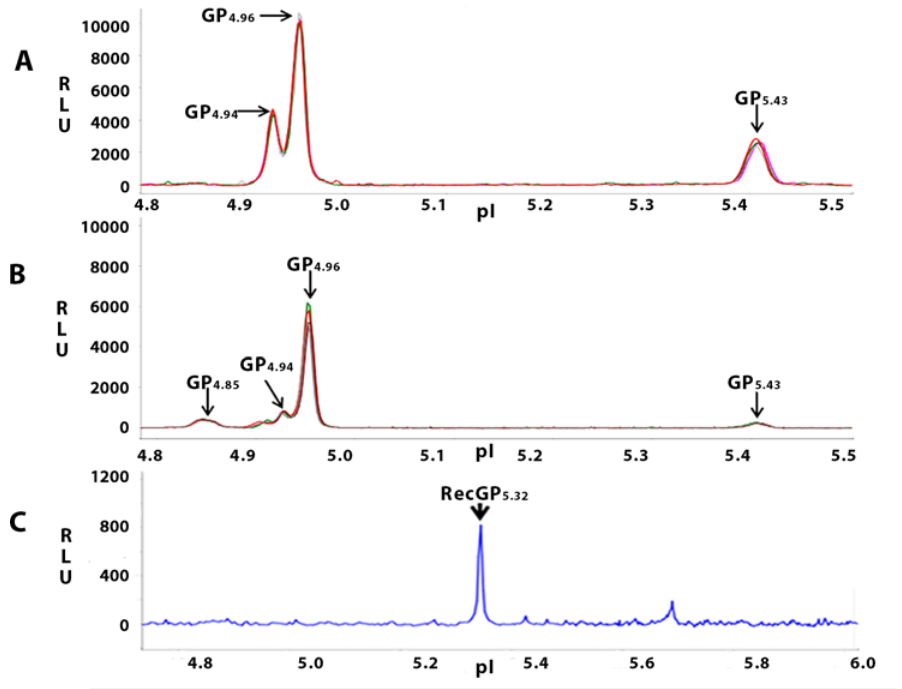
Fig 4. NIA profile of GRP78 in rat testicular- and cauda epididymal sperm. NIA for GRP78 was performed in 20ng of the respective sperm lysates in Premix of pI range 5 – 6 and spiked with pI standard 4 as the standard ladder. Figure shows a representative isoelectropherogram of GRP78 in rat testicular- and caudal- sperm (4 replicates represented by green, pink, red and grey peaks). Three peaks GP 4.94 , GP 4.96 and GP 5.43 , are observed for testicular sperm ( A ). For caudal sperm, an additional peak GP 4.85 is also observed ( B ). The pI of recombinant GRP78 is observed to be 5.32 ( C ) ‘ GP ’ represents the GRP78 peak, and the value in subscript indicates the pI of the respective peak. Experiments were performed thrice with 3 biological replicates and a minimum of 4 technical replicates for